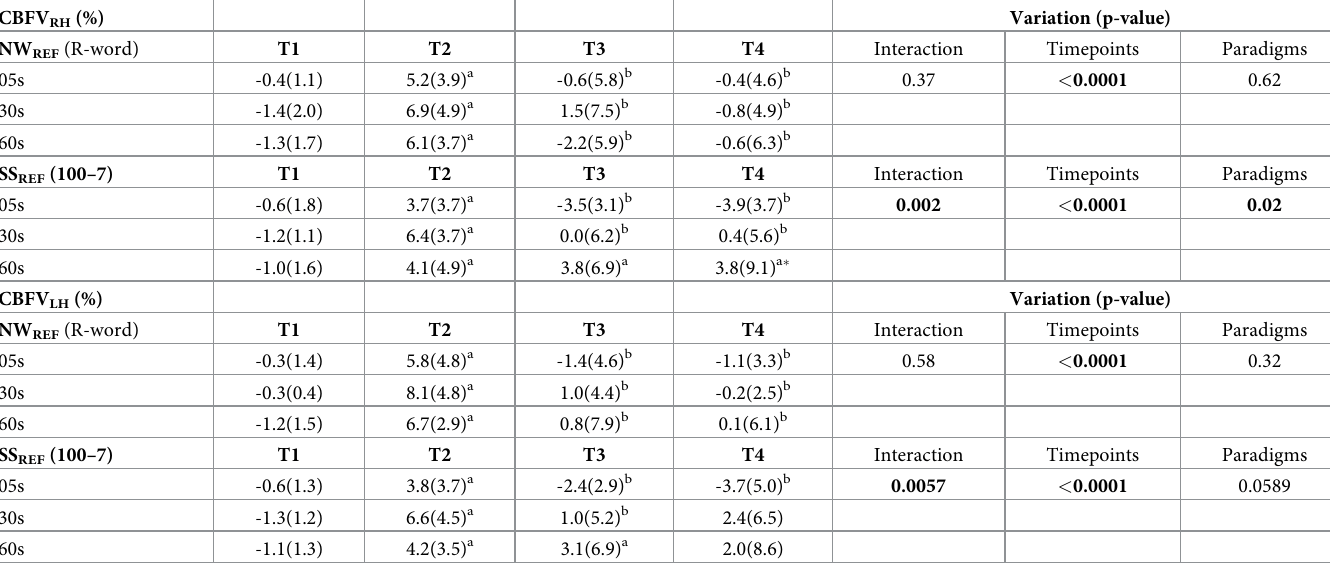
Table 2. Mean (SD) values of bilateral cerebral hemodynamic changes at each timepoint for different duration of NW REF and SS REF paradigms. CBFV RH (%) NW REF